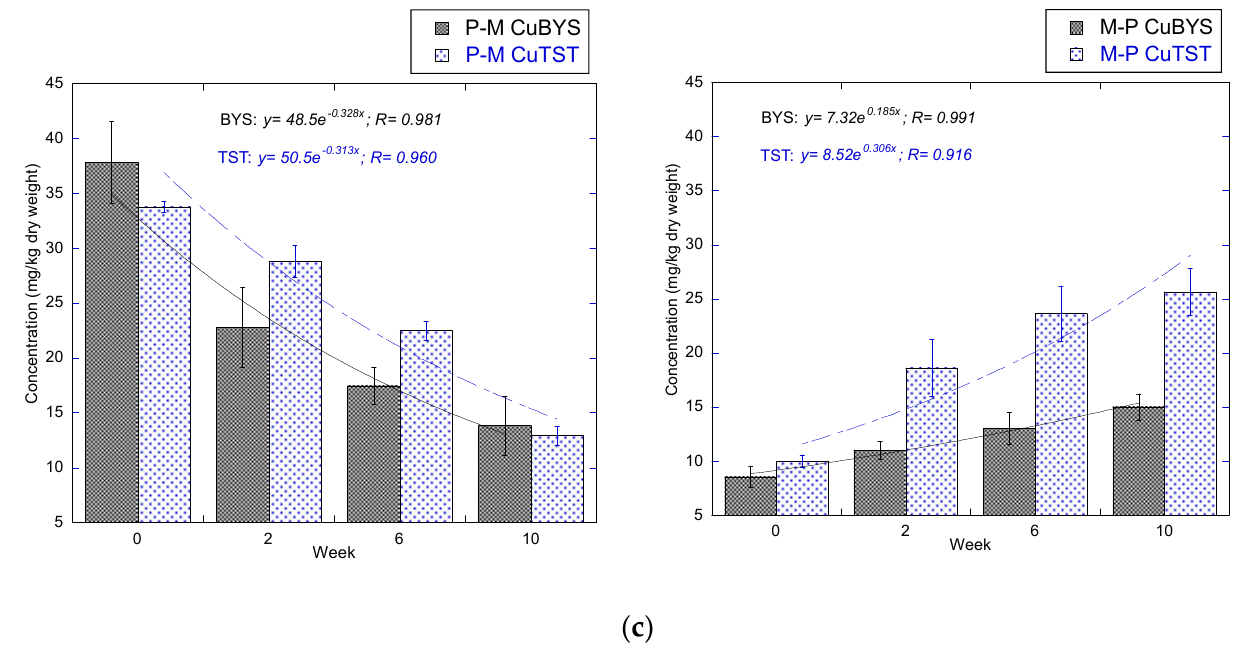
Figure 2. Accumulation and depuration of ( a ) Cd, ( b ) Zn, and ( c ) Cu concentrations (mg/kg dry weight) in the byssus (BYS) and total soft tissues (TST) of Perna viridis transplanted from Kg. Pasir Puteh to Kg. Sungai Melayu (P-M; left ), and from Kg. Sungai Melayu to Kg. Pasir Puteh (M-P; right ). Curve fits were based on exponential equations.